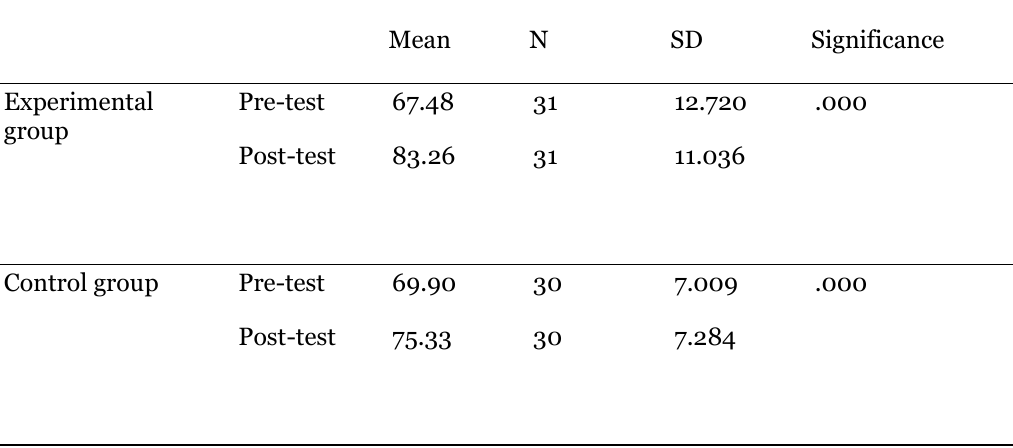
Paired Sample Statistics